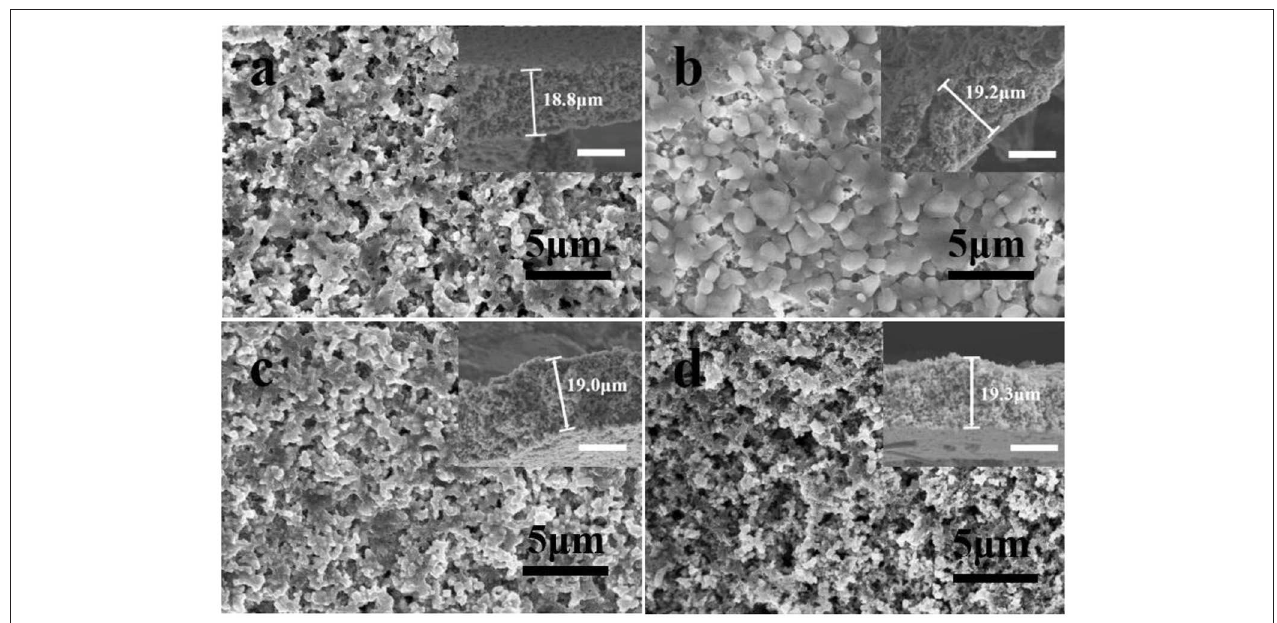
FIGURE 2 | SEM images and corresponding cross-section (inset) of (a) pristine MMSE, MMSE after (b) plating 10mA h/cm 2 , then (c) stripping 10mA h/cm 2 of Mg, and (d) MMSE after 1,000 cycles under a capacity of 1mA h/cm 2 at a current density of 10 mA/cm 2 . The white scale bar in the inset is 10 µ m. Electrochemical performance of MMSE symmetric cell.